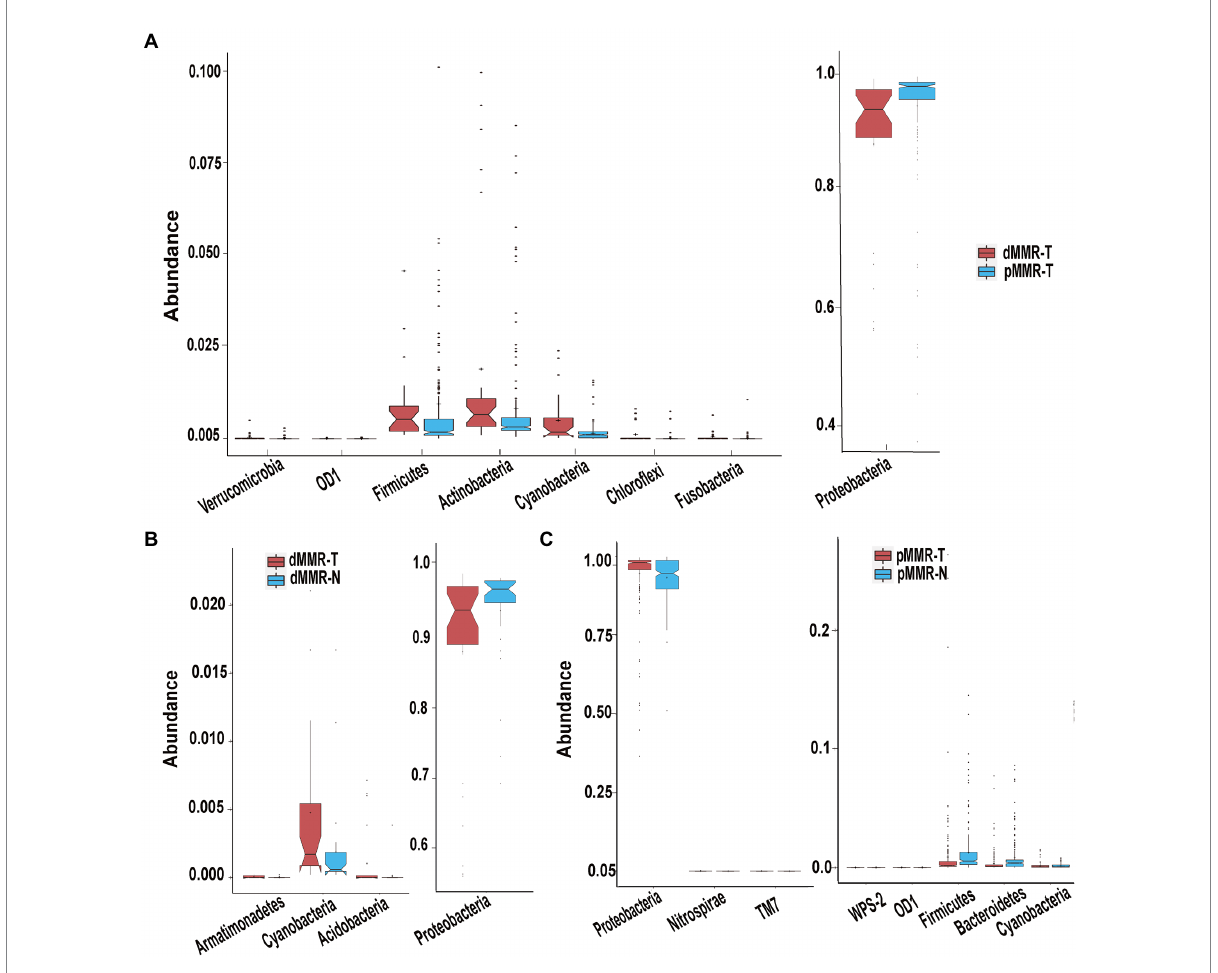
FIGURE 5 Different phyla among the dMMR and pMMR groups. Increased Phyla ( A , left panel) and decreased Phyla ( A , right panel) in dMMR-T group compared to pMMR-T group. Increased Phyla ( B , left panel) and decreased Phyla ( B , right panel) in dMMR-T group compared to dMMR-N group. Increased Phyla ( C , left panel) and decreased Phyla ( C , right panel) in pMMR-T group compared to pMMR-N